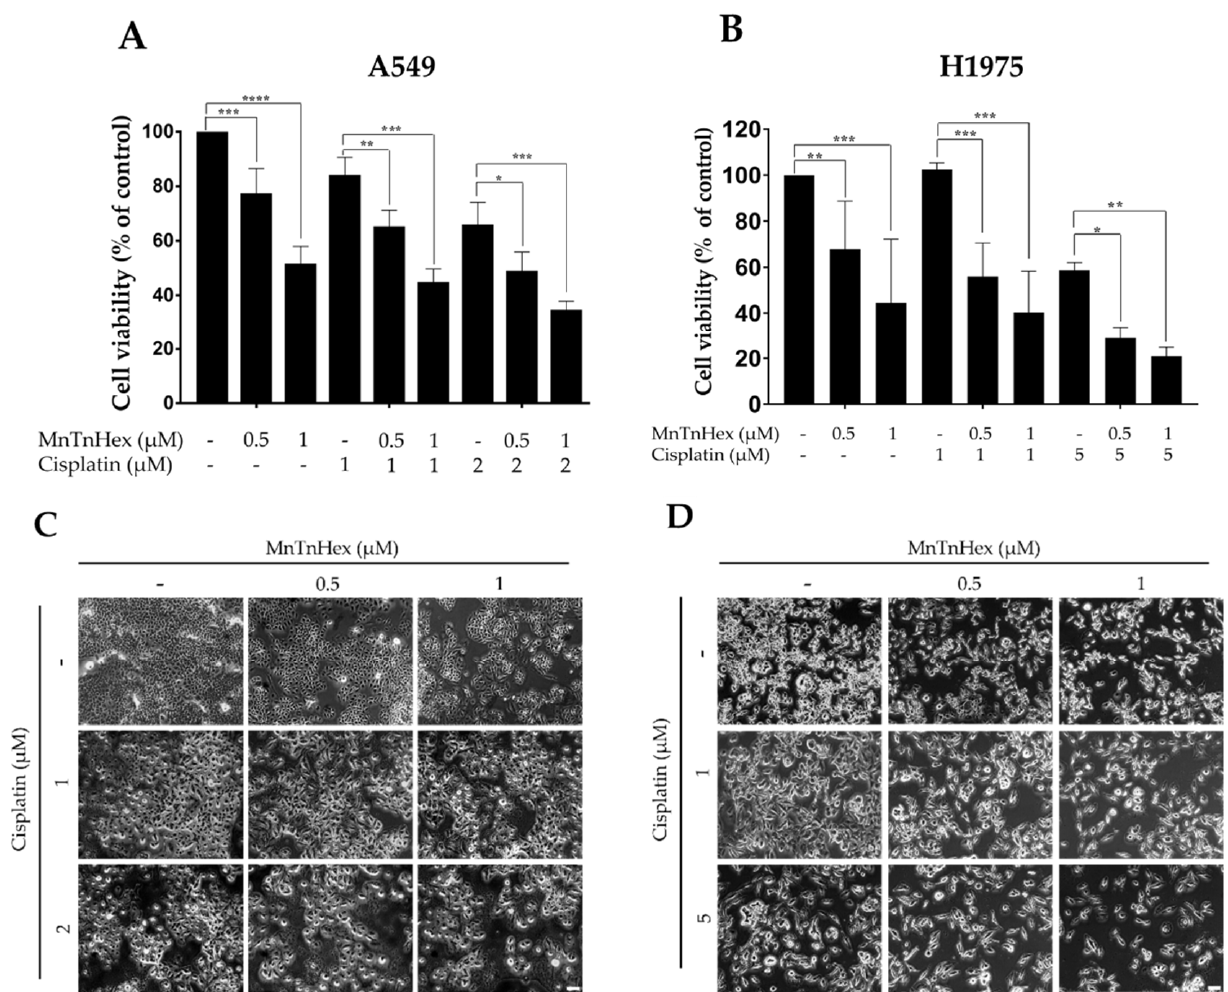
Figure 4. Cytotoxic effect of MnTnHex combined with cisplatin in A549 and H1975 cells. Cells were simultaneously treated with ( A ) MnTnHex (0.5 and 1 μ M) and cisplatin (1 and 2 μ M) in A549 cells and ( B ) MnTnHex (0.5 and 1 μ M) and cisplatin (1 and 5 μ M) in H1975 cells, for 72 h. This effect was evaluated using a CV assay. ( C ) A549 cell morphology upon treatment with MnTnHex and/or cisplatin. ( D ) H1975 cell morphology upon treatment with MnTnHex and/or cisplatin. Values represent mean ± SD (n = 4) and are expressed as percentages relative to control cells. * p < 0.05, ** p < 0.01, *** p < 0.001 and **** p < 0.0001 (one-way ANOVA with Tukey’s multiple comparisons test) when compared with control and cisplatin-treated cells. Scale bar = 100 μ m.